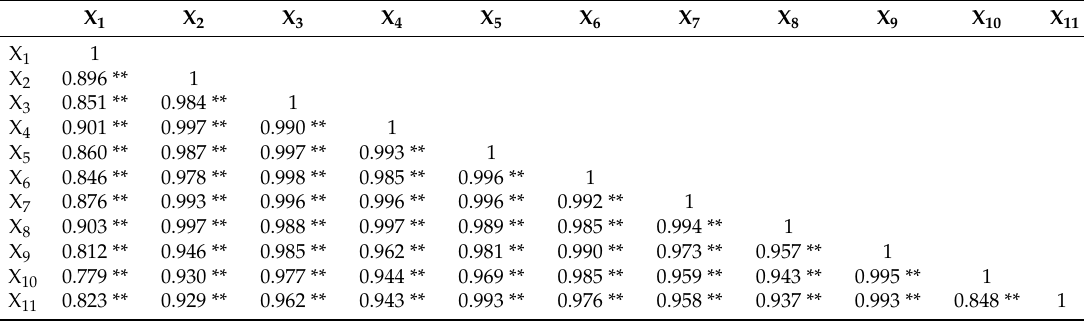
Table 4. Correlation test of urbanization and eco-environment indicators of BTH in